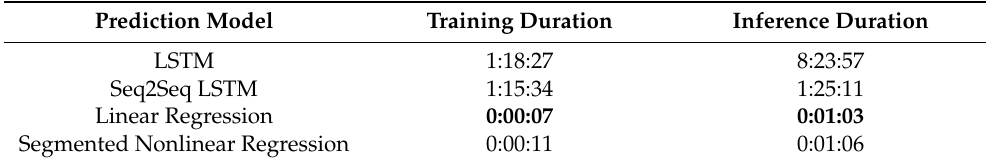
Table 2. Average time consumption of the training process, and 10-year inference for each model on every sensor. We report the duration for both cases in h:mm:ss format, where h is hours, mm is minutes, and ss is seconds. The fastest time is in